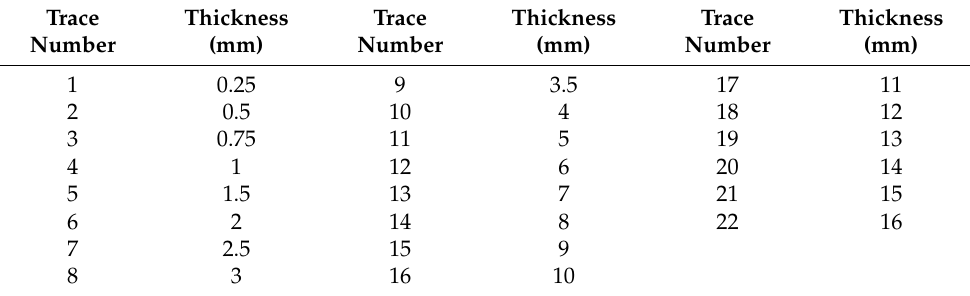
Table 1. List of the 22 different values of the fracture apertures (0.25–16 mm) that were filled with PVC.